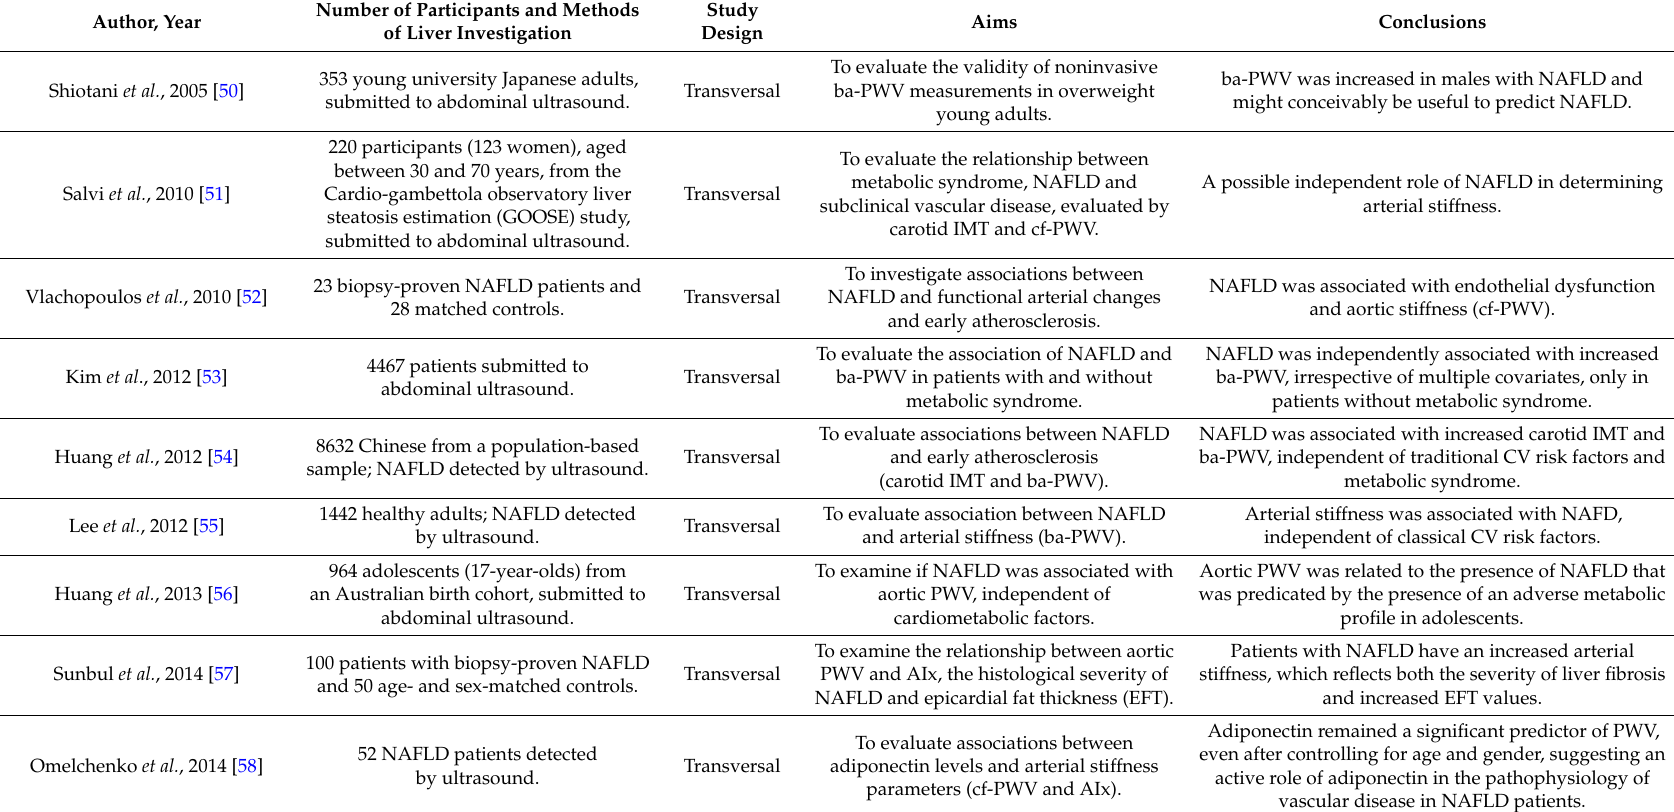
Table 1. Studies evaluating associations between non-alcoholic fatty liver disease (NAFLD) and arterial